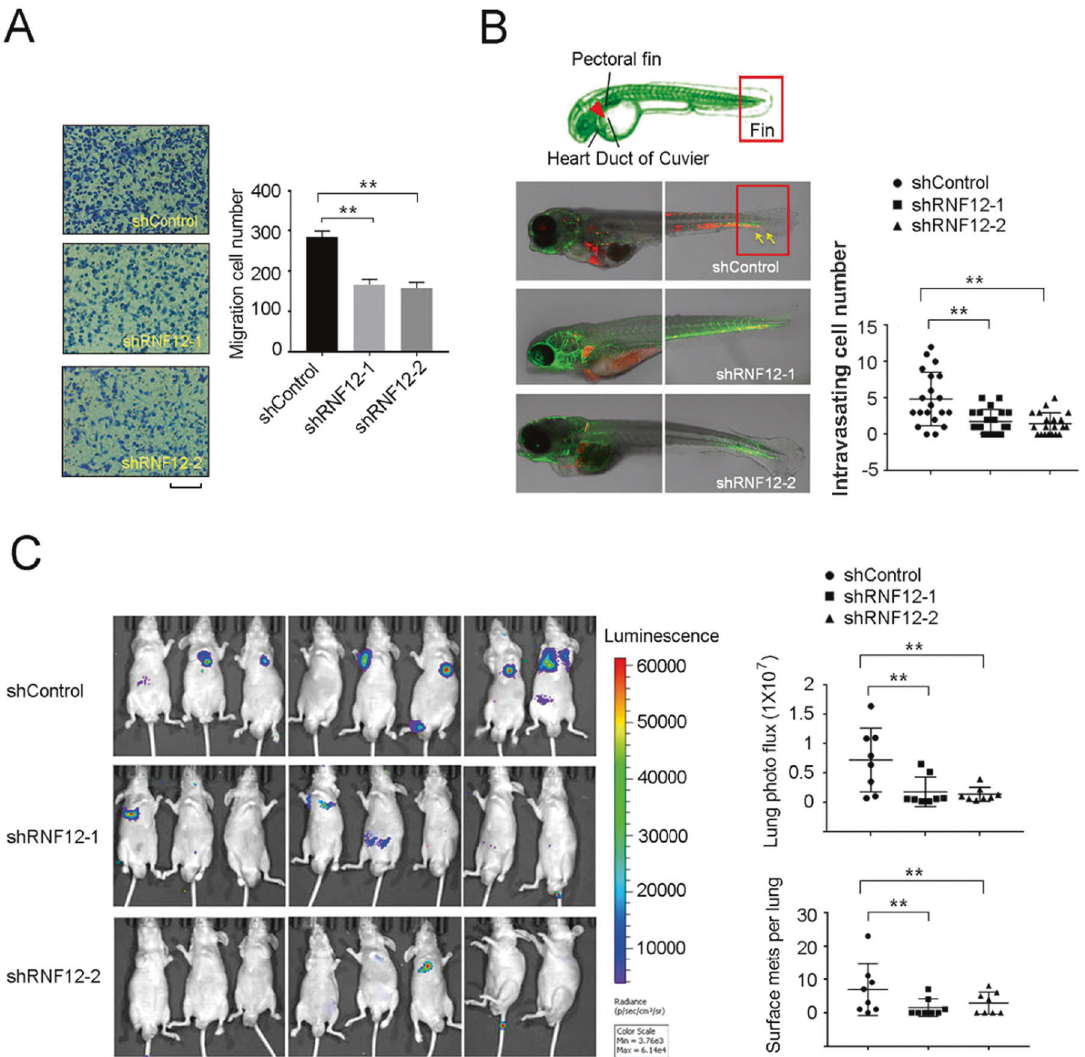
Scale bar = 50 μ m. B Schematic diagram of the zebra fi sh embryo; shRNF12 or control MDA-MB-231 cells were injected into the Duc of Cuvier of zebra fi sh embryos at 48 h post fertilization. Representative images of zebra fi sh at 5 dpi are shown. Percentage of zebra fi sh